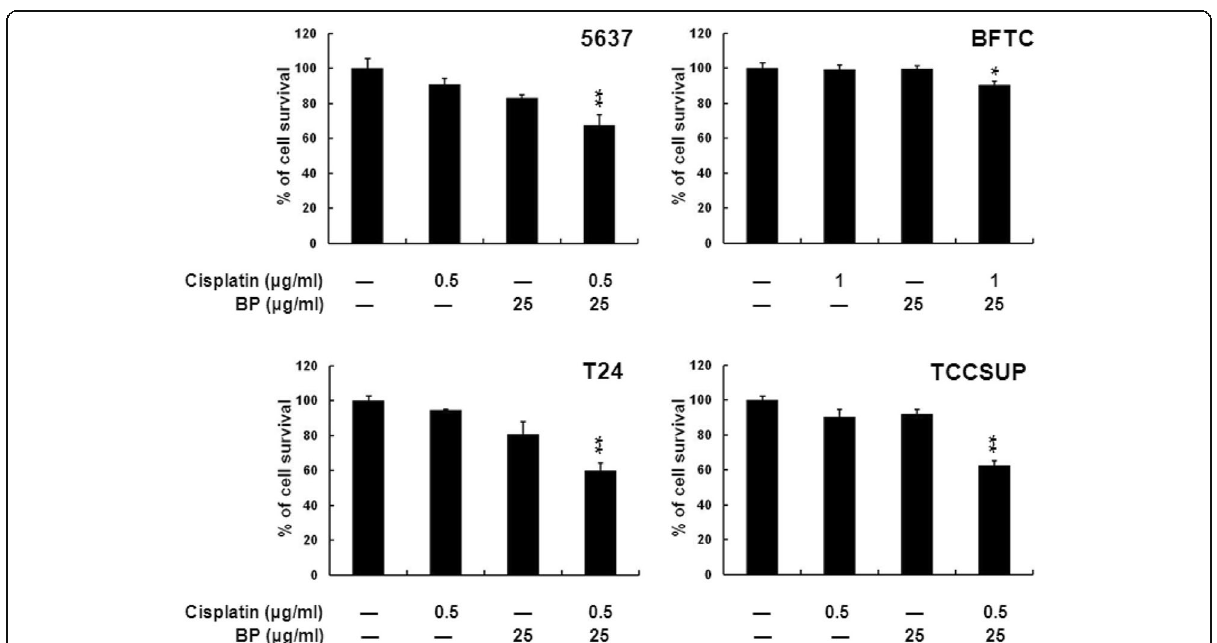
Fig. 6 The synergic effects of BP on combination therapy with cisplatin. Human bladder cancer cells were treated with cisplatin or BP only, or a combination therapy for 24 h, and analyzed with MTT assay. Data are presented as means ± S.D. from three different experiments. * p < 0.05 versus vehicle; ** p < 0.01 versus vehicle